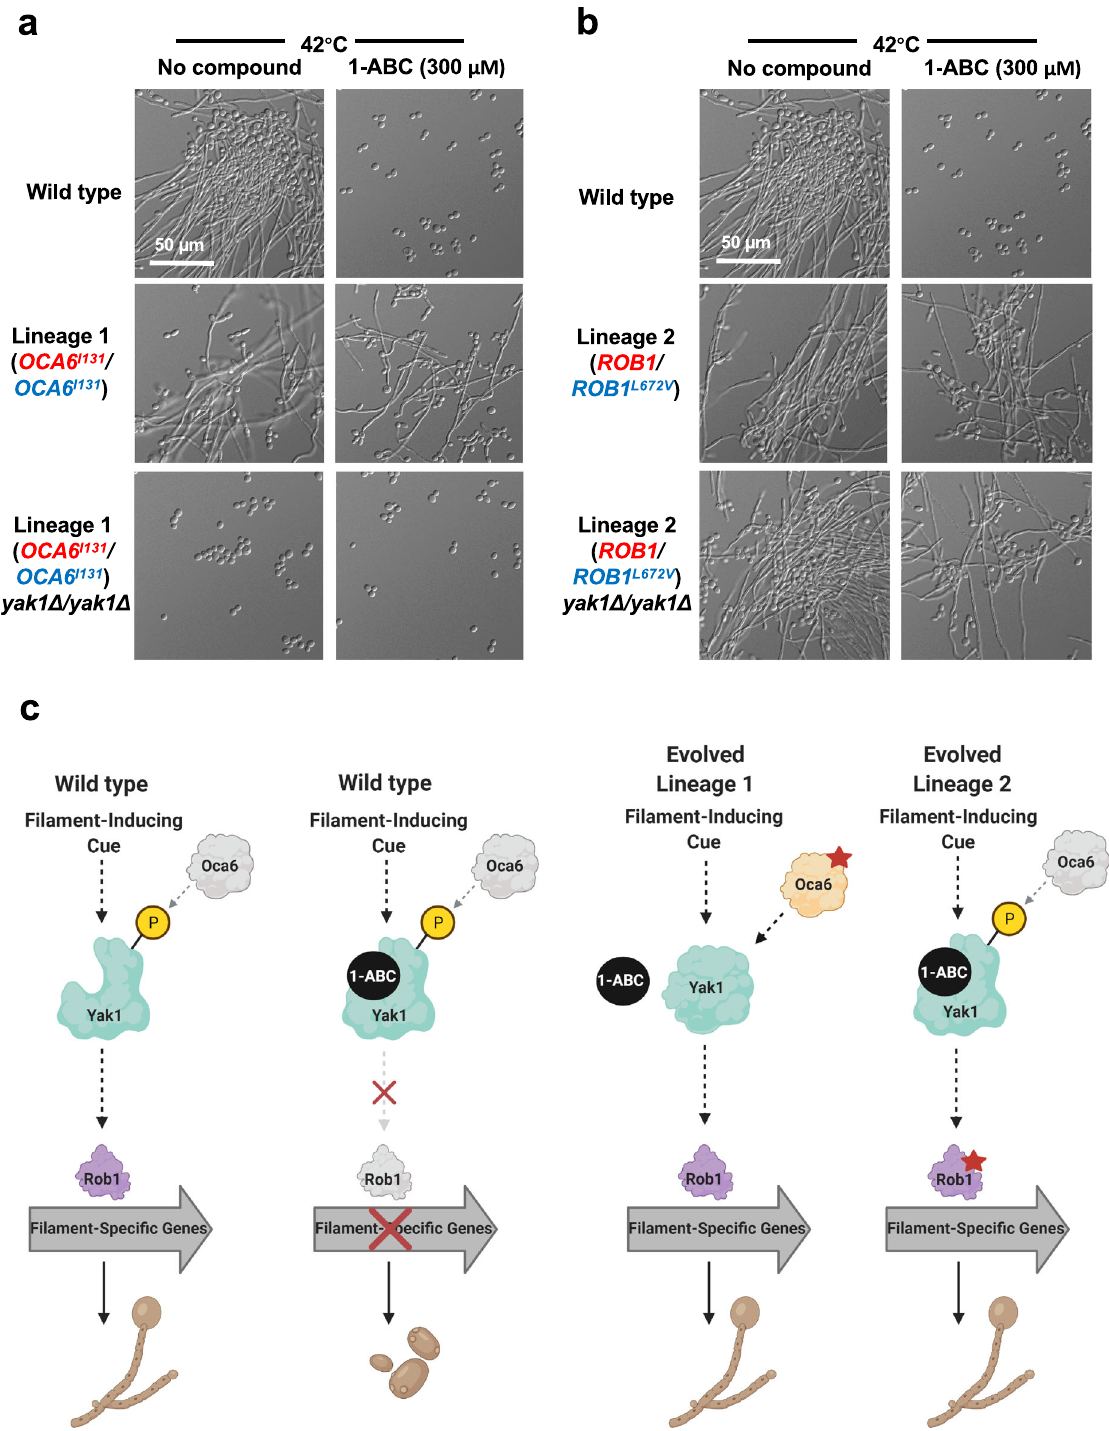
Fig. 5 Oca6 acts upstream and Rob1 acts downstream of Yak1 to enable C. albicans fi lamentation. a Deletion of YAK1 in Lineage 1 blocked C. albicans fi lamentation in response to high temperature. Strains of C. albicans were grown in YPD at 42 °C for 6 h in the absence or presence 1-ABC, as indicated. Data represent two biological replicates. b Deletion of YAK1 in Lineage 2 did not affect the mutant phenotype and C. albicans continued to fi lament in the presence of 1-ABC. Strains of C. albicans were grown as described in ( a ). Data represent two biological replicates. c Model depicting proposed mechanisms by which Yak1, Oca6, and Rob1 interact in regulating C. albicans hyphal morphogenesis in the absence or presence of 1-ABC. Created with